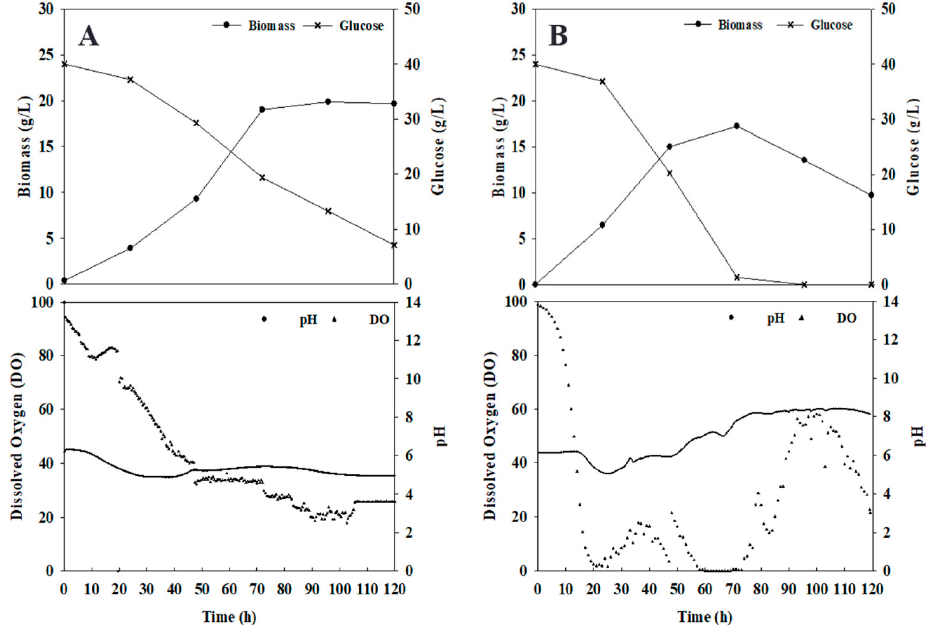
Figure 5. Biomass concentration, glucose consumption, pH and dissolved oxygen (DO) of Mortierella alpina FU30797 batch cultivation in the bioreactor with ( A ) glucose and ( B ) enzymatic hydrolysate for 5 days (initial carbon source (as glucose) concentration was 40 g/L).